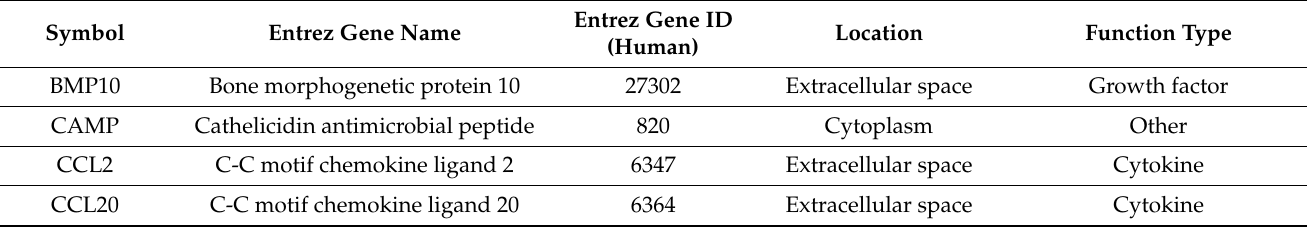
Table 1. Antimicrobial peptides (AMPs); chemokines, cytokines, and biomarkers (CCBMs); and other mediators were identified from ingenuity pathway analysis (IPA, Qiagen, Germantown, MD, USA), combined into a single dataset below, annotated for their IPA symbol, Entrez Gene name, Entrez Gene ID (human), cellular location, and function type.